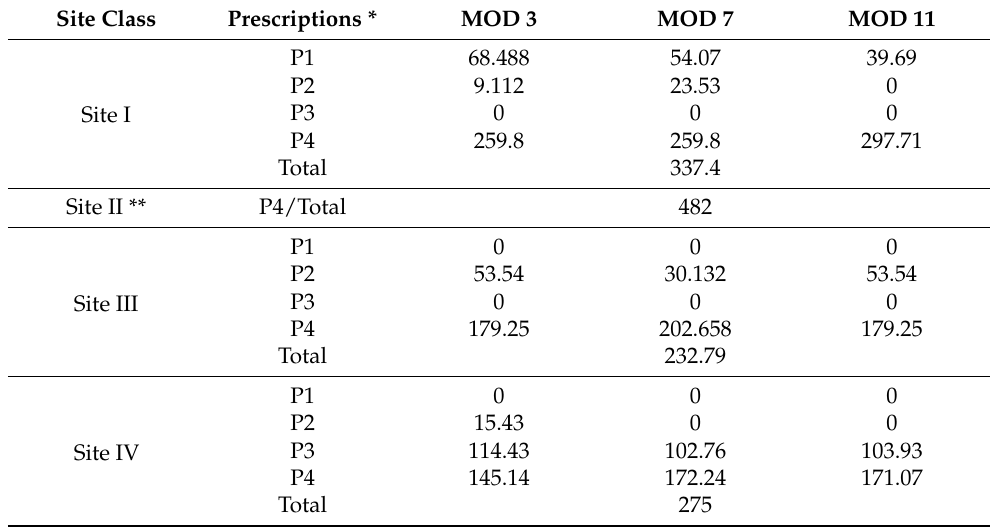
Table 4. Optimal land allocation (ha) for different site productivity classes in the case of water-use- constrained LEV-maximization